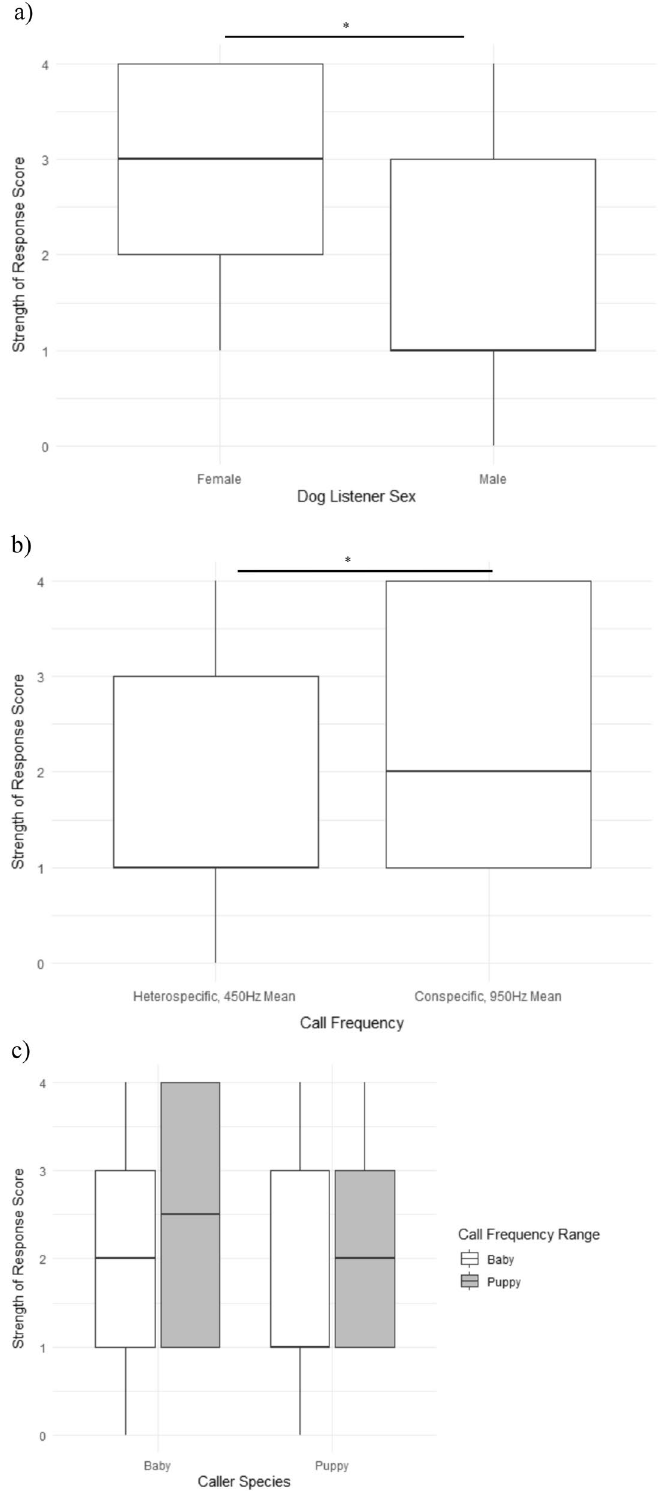
Figure 2. Boxplots of Score of intensity of dogs’ response to distress cries from human babies and puppies in either their natural or modified frequency (950 Hz or 450 Hz) by ( a ) Sex, ( b ) Call frequency, and ( c ) the interaction between Caller Species and Call frequency. Male dogs’ reactions were scored lower than female dogs’ (F 1,23 = 5.5, p = 0.027), while reactions to cries in the conspecific range were given higher scores than cries in the heterospecific range (F 1,67 = 4.3, p = 0.042), regardless of Caller species (F 1,67 = 5.5, p = 0.488). There was no significant interaction between Caller species and Call frequency (F1,68 = 0.1, p =